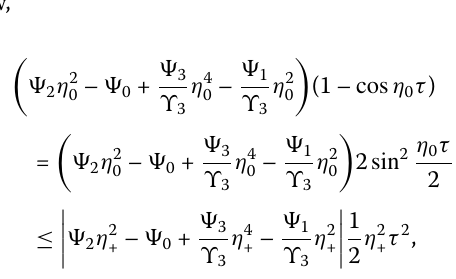
Figure 6 Phase plots for different p at τ = 2.8985. The rest of the parameters are taken as given in the text